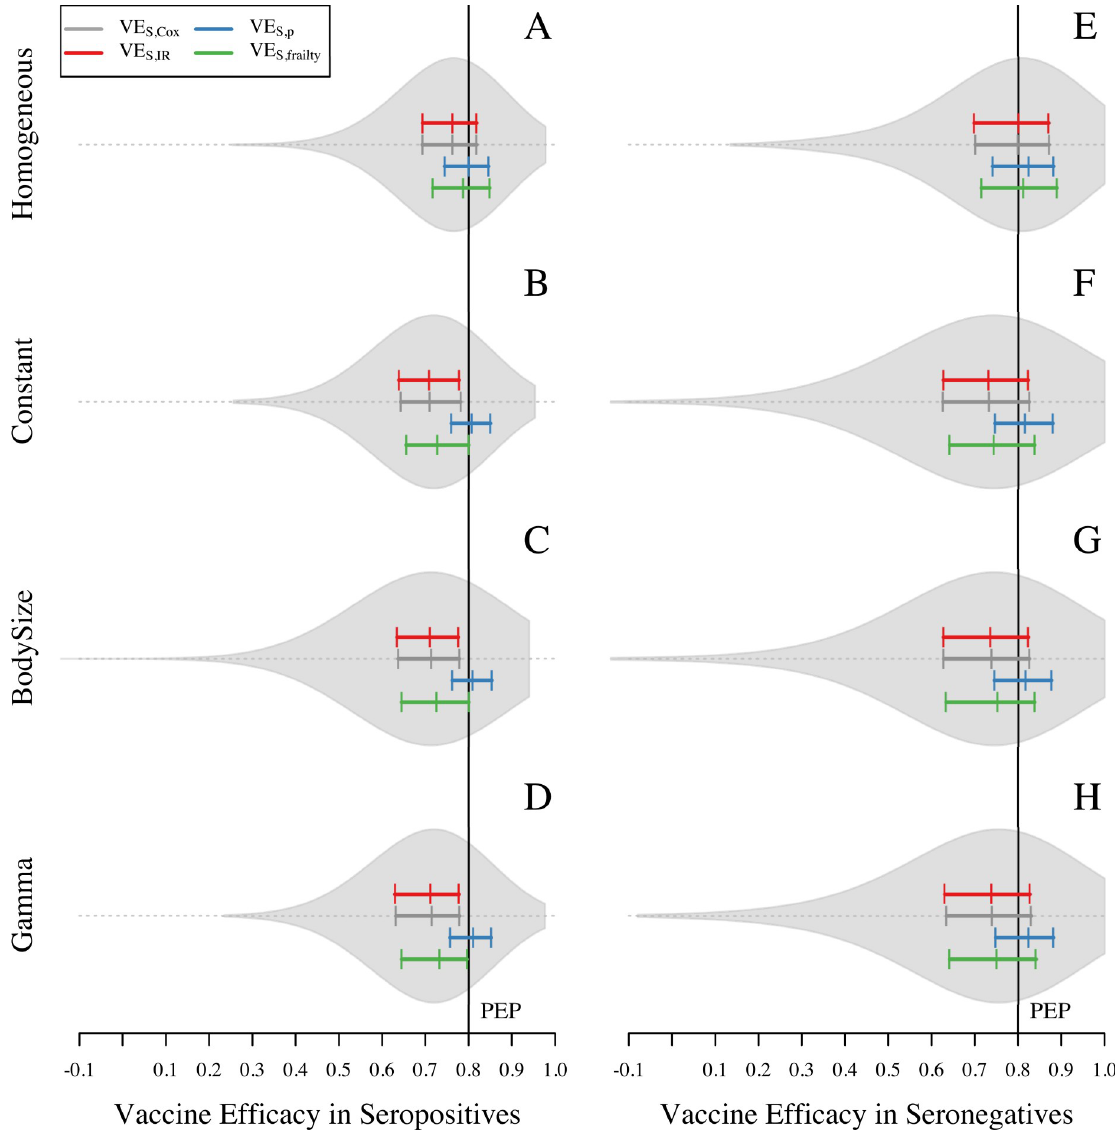
Fig 6. Vaccine efficacy in four scenarios about heterogeneous exposure to DENV for seropositive and seronegative individuals. Violin plots show the shape of the distribution of VE S,Cox estimates. The colored solid lines show the 25, 50, and 75 quantiles for VE S,Cox , VE S,p , VE S,IR , and VE S,frailty (gray, blue, red, and green, respectively). Black solid line represents the individual input of vaccine efficacy: VE = 1 –PEP = 1—RR inf|exp RR dis|inf = 0.8. The left panel corresponds to VE S in seropositives and the right panel corresponds to the VE S in